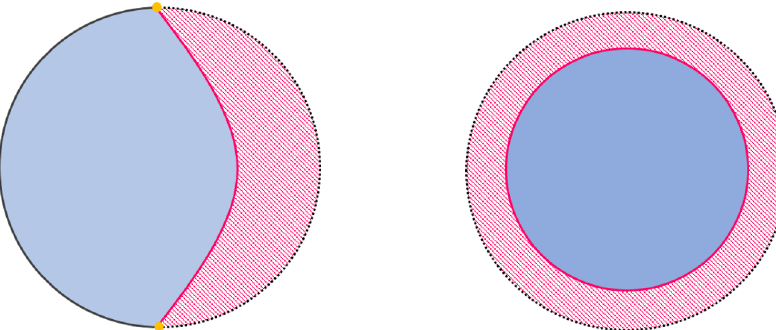
Figure 11 . Left : an AdS brane embedded into a higher dimensional bulk. The shaded magenta region, including the dashed line of the AdS boundary, has been integrated out. The two points in yellow (a circle, when rotated along the symmetry axis) represent two-dimensional defect CFTs, which are coupled to a bath CFT 3 . The defect CFT is dual to the brane. Right : a timeslice of the dS brane embedded into a higher dimensional bulk. The blacked dashed line corresponds to the part of the boundary which has been integrated out, along with the shaded magenta